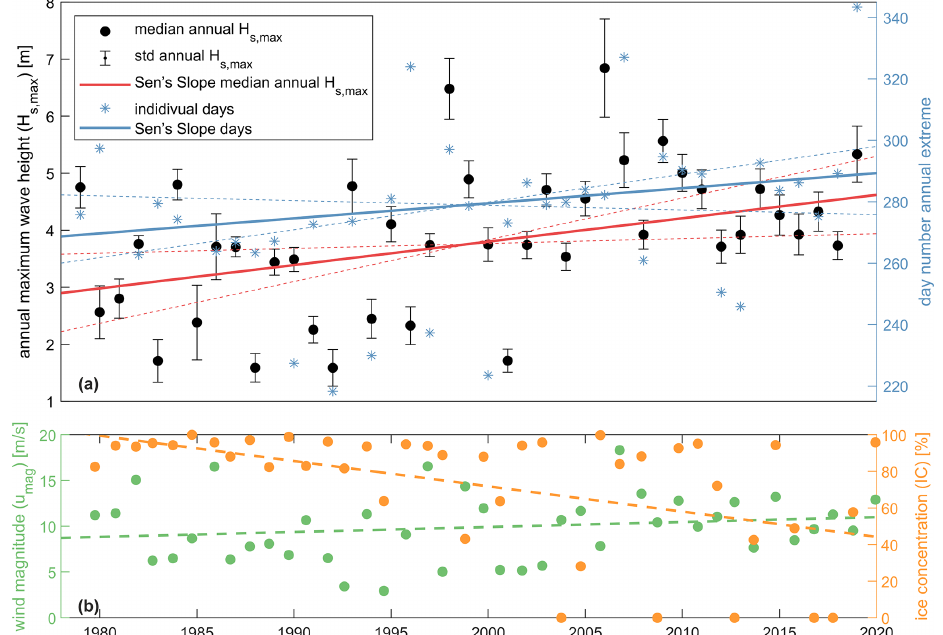
Figure 13. (a) Time series of the annual maximum wave height ( H s , max ) over the last 40 years as simulated with SWAN for the inter- mediate domain with an estimate of day number of the associated peak. The range represents 1 standard deviation (SD) based on spatial variability within the domain. The solid line is Sen’s slope including the dashed uncertainty range for an alpha of 0.05 (dashed lines). (b) Ice concentration and wind speed during the storm based on ERA5 (circles) including linear fit (dashed